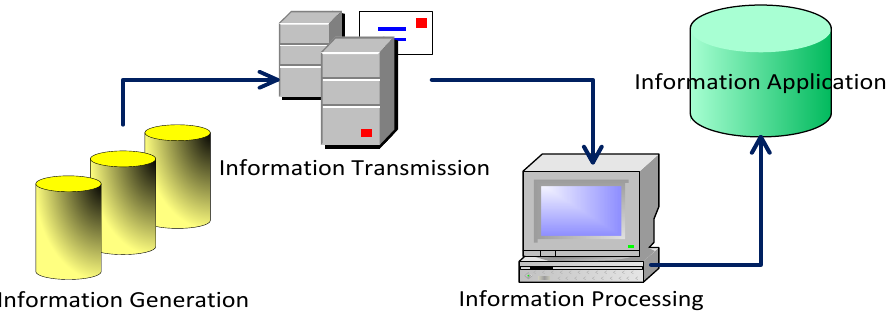
Figure 4. 4-layer architecture for IoT